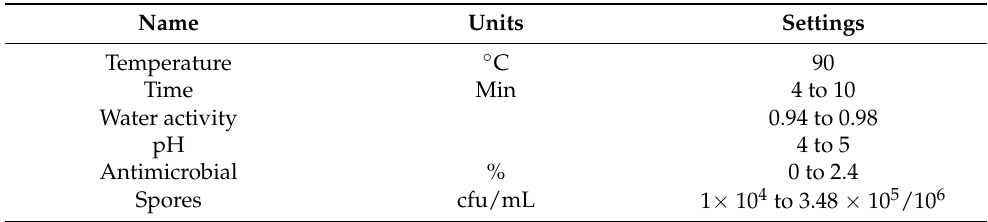
Table 1. Values of the quantitative